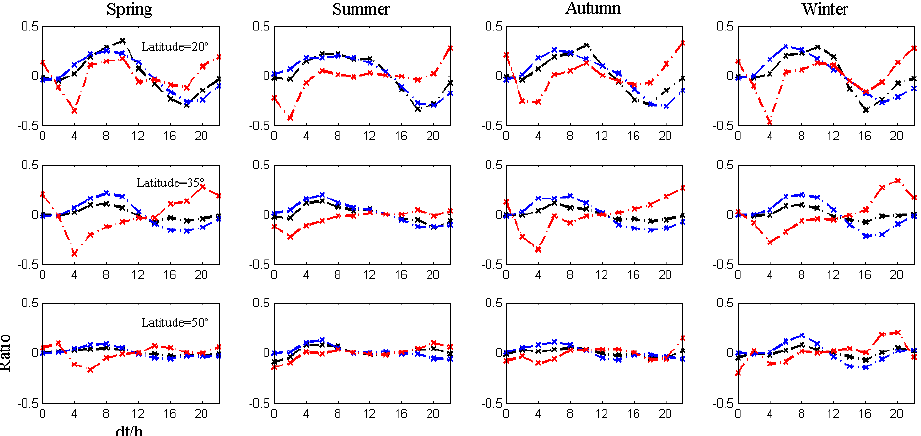
Figure 9. Ratio variation in TEC (black broken line), Nm F2 (blue broken line) and slab thickness (red broken line) for all seasons in